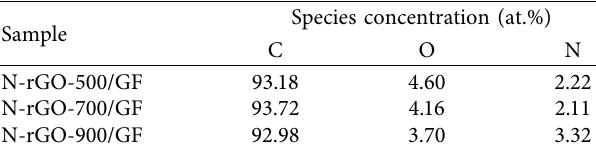
Table 3: N special content of N-rGO measured by XPS. Sample